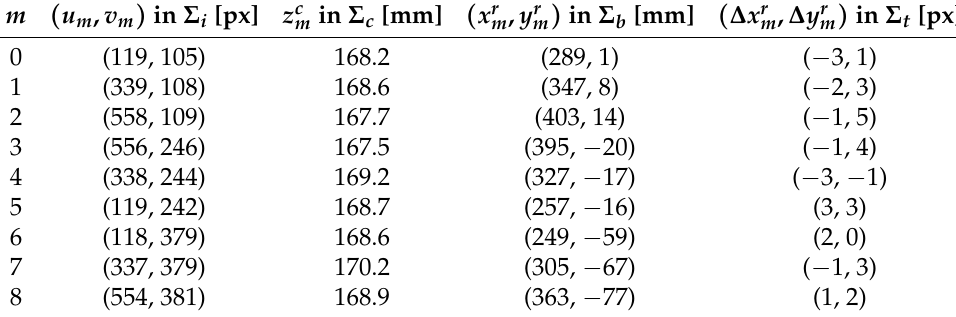
Figure 8. ( a ) Captured image of the tablet display by RGB-D camera; ( b ) binarized image to detect displayed black dots. Table 2. Created data for two-stage optimization.